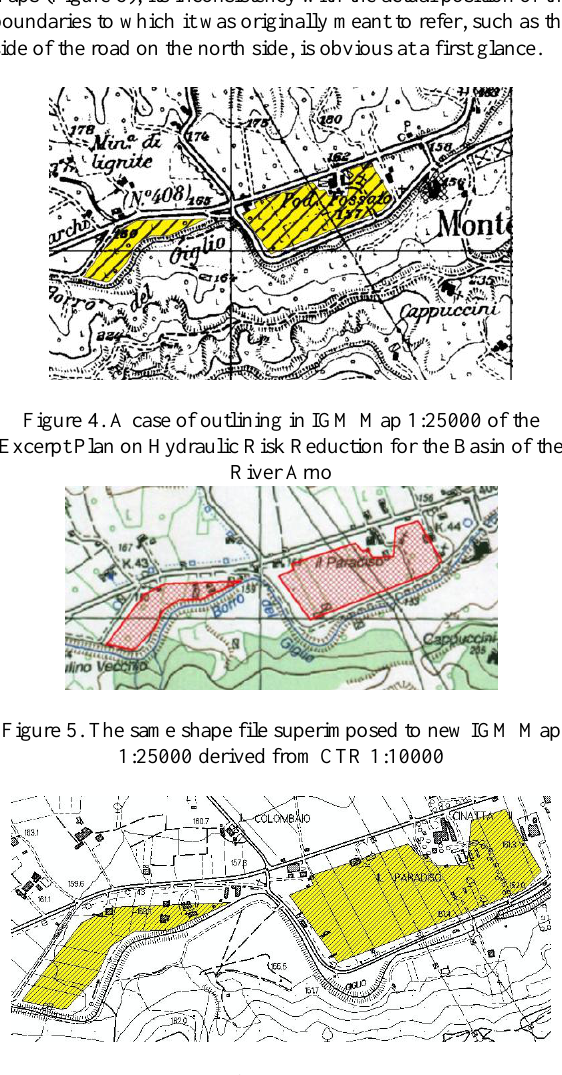
Figure 6. The same shape file superimposed to cartography at a larger scale (CTR